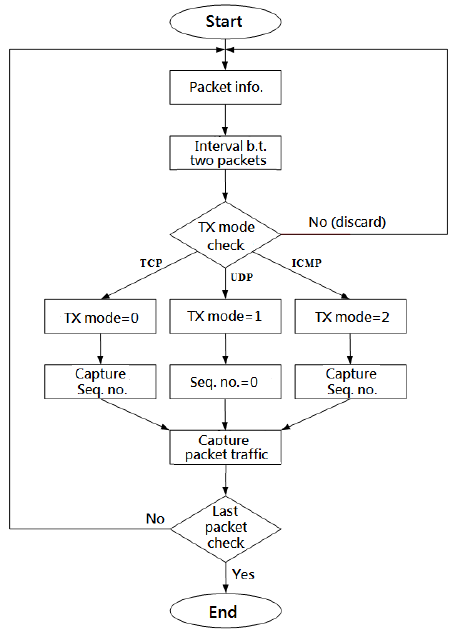
Figure 9. The procedure of data preprocessing for packet features capturing.